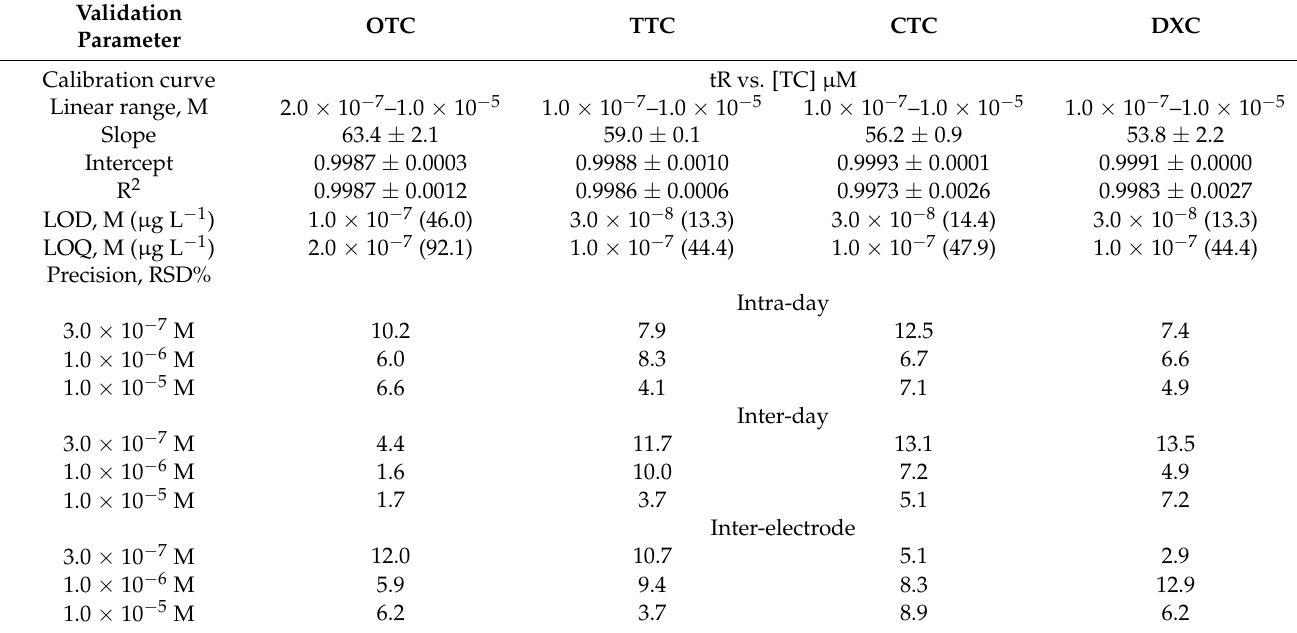
Table 4. Analytical figures of merit obtained with the proposed TC-selective electrode as detector in